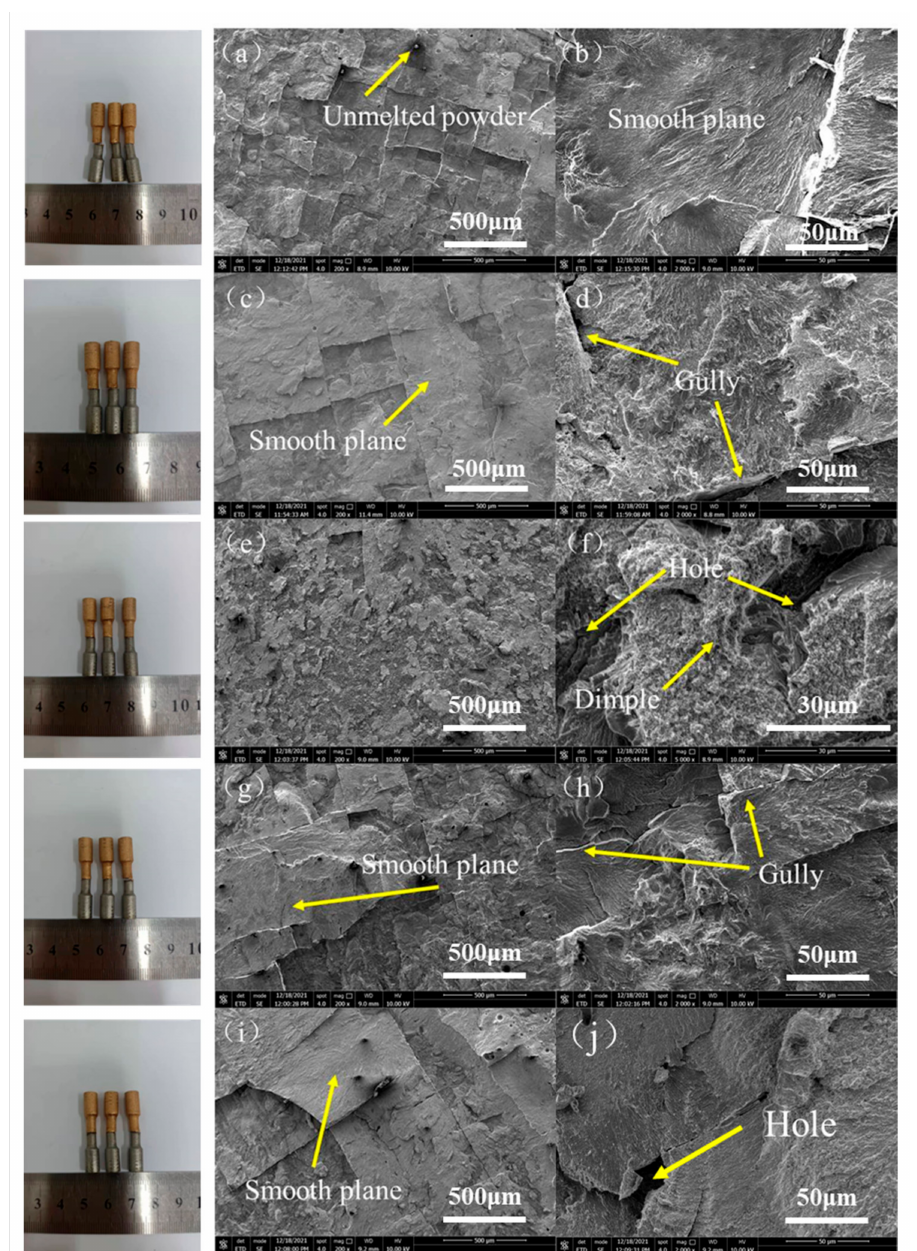
Figure 10. SEM images of fracture of sample ( a ) No.1 (200 × ); ( b ) No.1 (2000 × ); ( c ) No.2 (200 ×